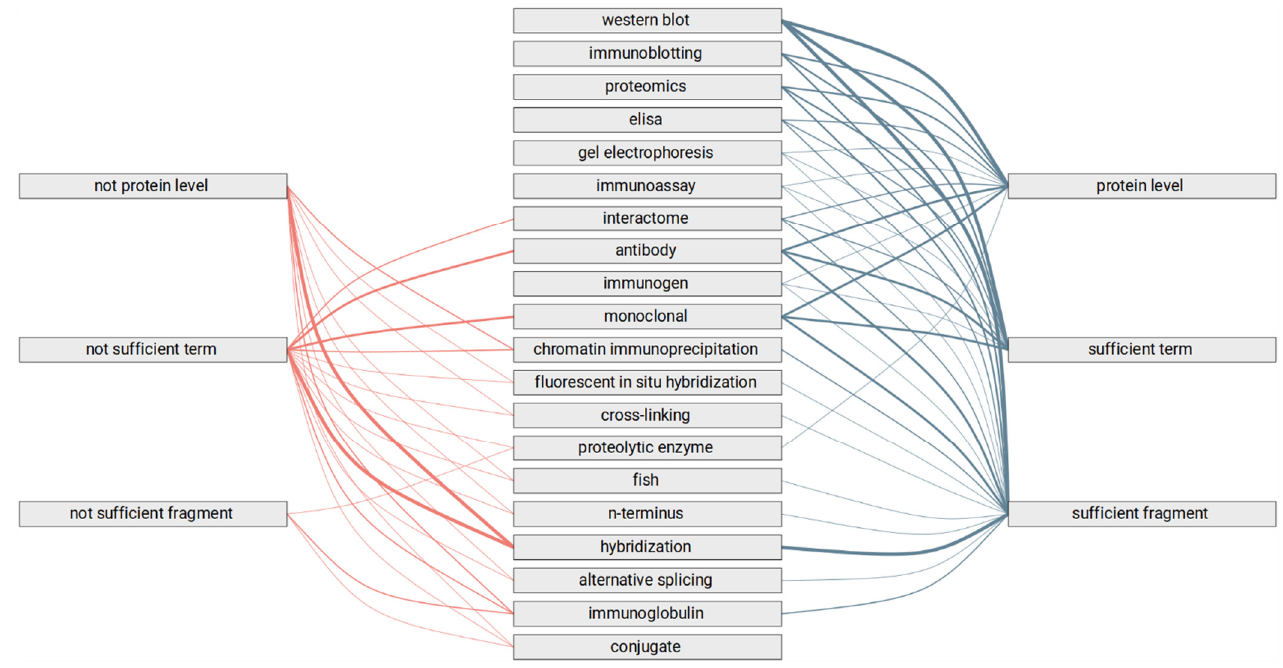
Figure 6. Association between the terms from the protein category of the dictionary and answers obtained during the manual review. Thicker lines connecting the term and an answer mean more cases. Blue lines connect terms and positive answers. Red lines connect the terms and negative answers.